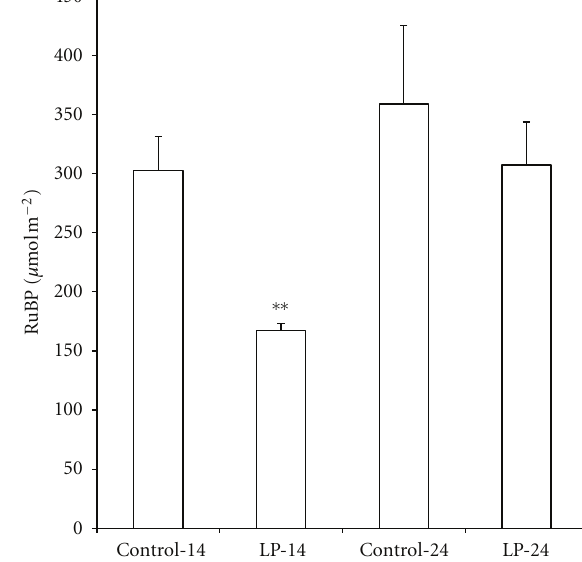
Figure 5: Leaf RuBP content in soybean plants grown with original pots (Control) and with larger pots (LP). Summary of growth conditions is described in Figure 1. Vertical bars, S.D. ( n = 3). ∗∗ P < 0 . 01 ( t -test) when compared with